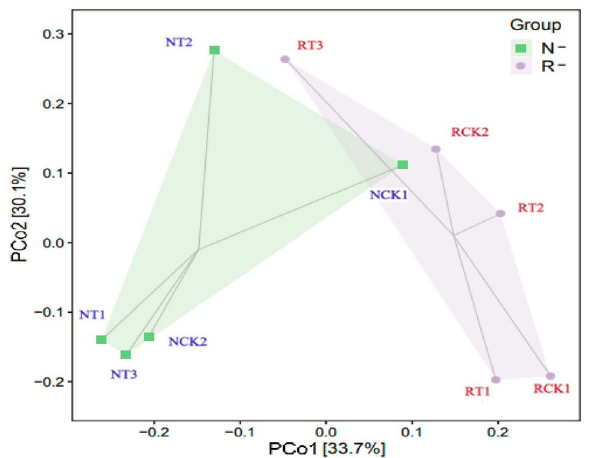
Figure 3. PCoA plot of different soil samples based on Bray–Curtis distance measures. Values on PCoA axes indicate the percentages of total variation explained by each axis and the relative abundances of OUT were used as input in the analysis. RCK1: R-soil in CK1; RCK2: R-soil in CK2; RT1: R-soil in T1; RT2: R-soil in T2; RT3: R-soil in T3; NCK1: N-soil in CK1; NCK2: N-soil in CK2; NT1: N-soil in T1; NT2: N-soil in T2; NT3: N-soil in T3.